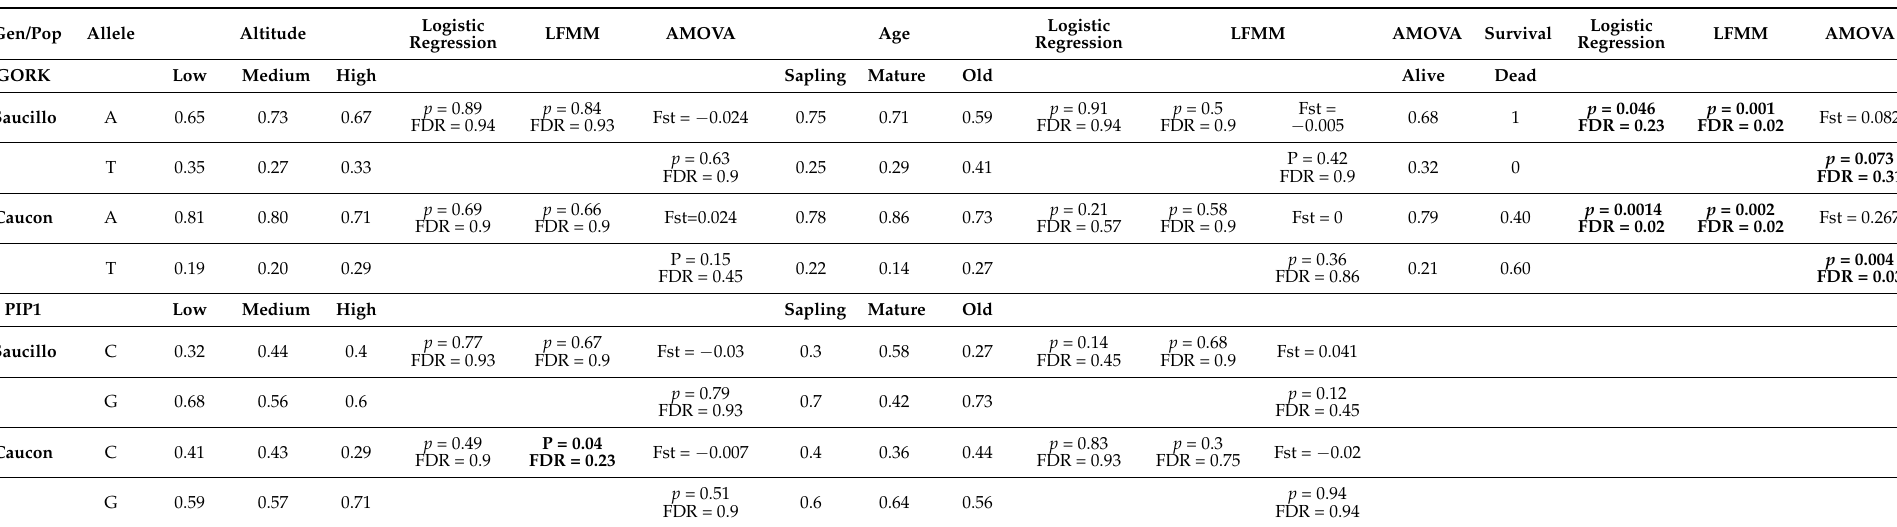
Table 1. Allele frequencies by altitude, age and survival, and results of logistic regression and LFMM analysis (GEA analysis) and Fst (AMOVA) based on two SNPs in GORK and PIP1 gene for Saucillo and Caucon populations. Saucillo—Low: N = 15, Middle: N = 14, High: N = 6, Young: N = 11, Mature: N = 12, Old: N = 12; Alive (mature and low): N = 11, Dead (mature and low): N = 4. Caucon—Low: N = 16, Middle: N = 38, High: N = 14; Sapling: N = 22; Mature: N = 22, Old: N = 24; Alive (mature and low): N = 19, Dead (mature and low): N = 5. Significant results are highlighted in bold. FDR: False Discovery